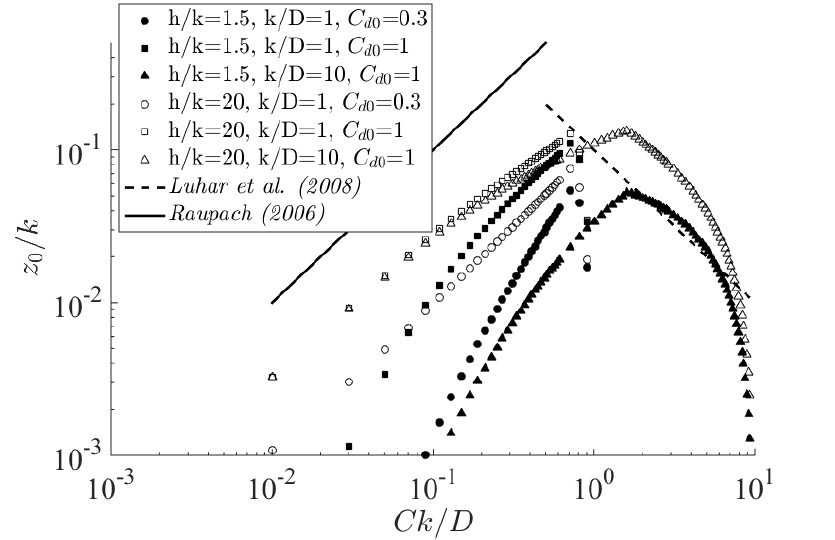
Figure 15. Hydraulic roughness as a function of the spatial